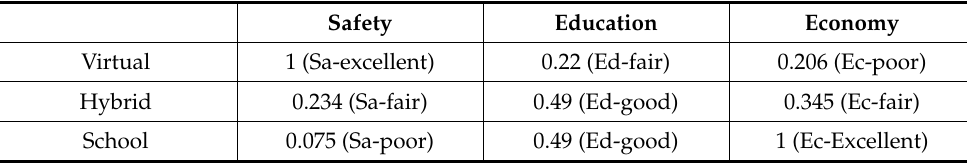
Table 17. Winning Intensity for the 3